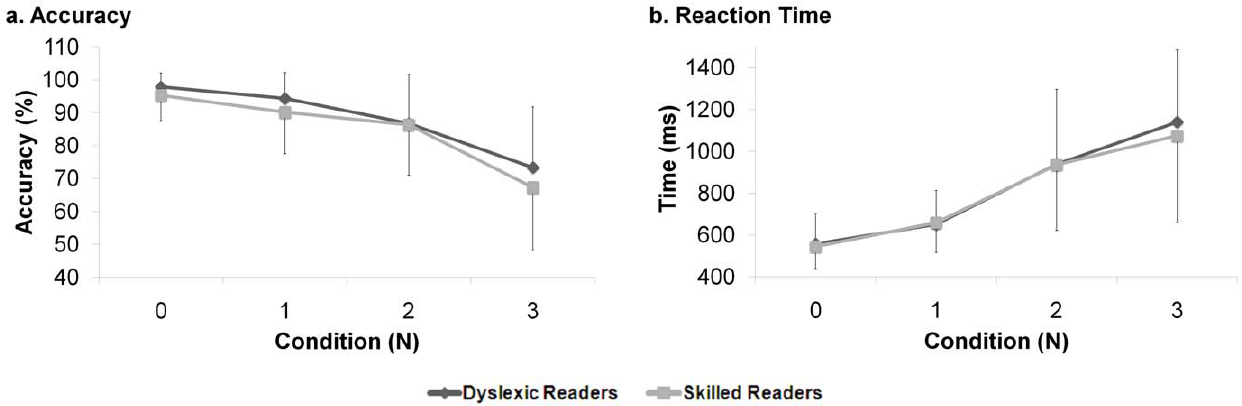
Figure 2. The N-Back Behavioral Results. The dyslexic (dark line) and skilled (light line) readers’ mean (a) accuracy and (b) reaction time under each of the N-Back task conditions. Error bars represent group’s standard deviation.